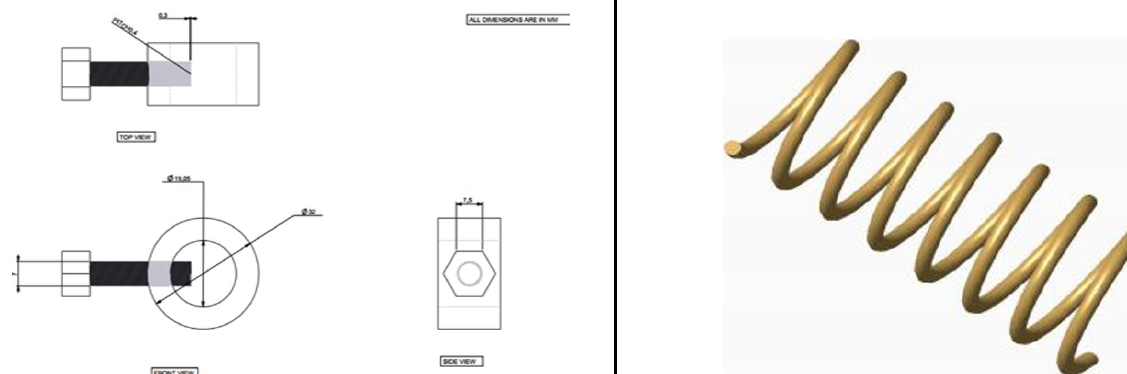
FIG.17 3D VIEW OF STOPPER